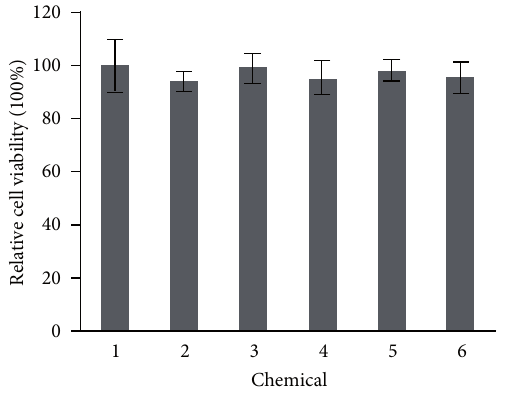
F 3: Cytotoxicity of compounds 1–6 in RAW264.7 cells.